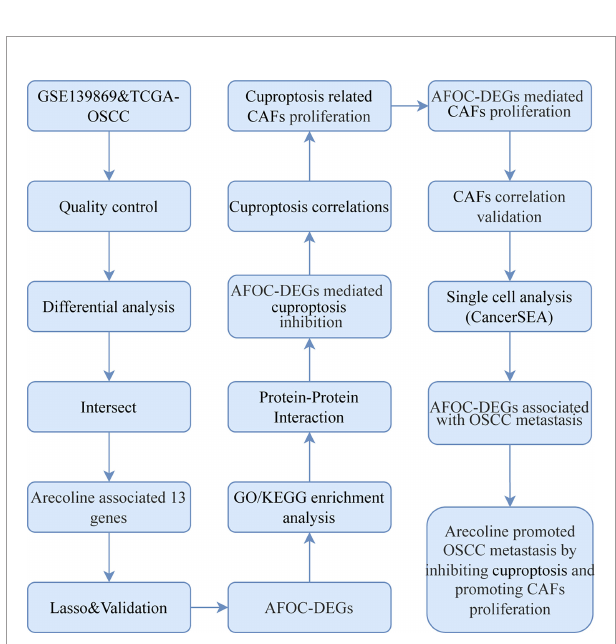
FIGURE 1 | Flowchart for bioinformatics analysis of publicly available data from GEO, TCGA, and FibROAD databases. AFOC-DEGs, arecoline- associated fi brosis-related oral cancer differentially expressed gene; LASSO, least absolute shrinkage and selection operator; GO, Gene Ontology; KEGG, Kyoto Encyclopedia of Genes and Genomes; CAFs, cancer-associated fi broblasts; OSCC, oral squamous cell carcinoma; TCGA, The Cancer Genome